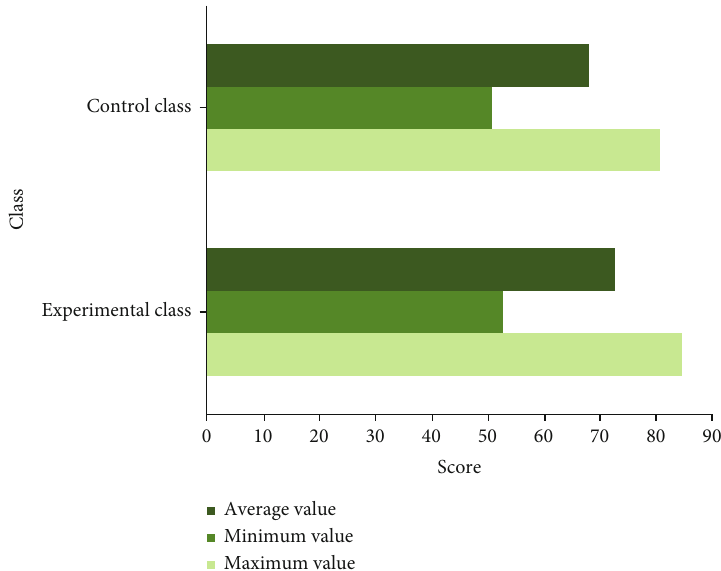
Figure 3: Comparison of the results of aerobics skills test between the experimental class and the control class.